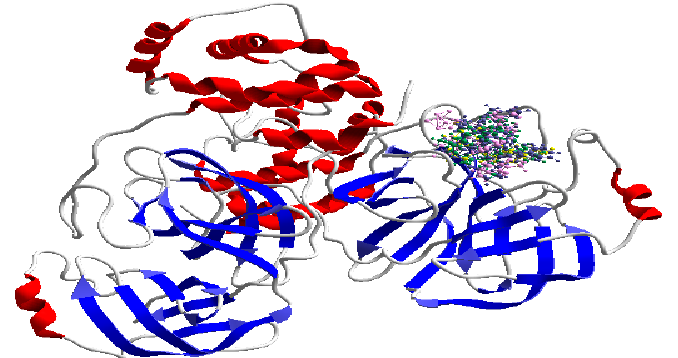
Figure 5. Docking of the studied molecules into the SARS-CoV-2-M Pro . Table 3. Main interaction energies between the studied molecules and the SARS-CoV-2-M Pro , in eV. Molecule